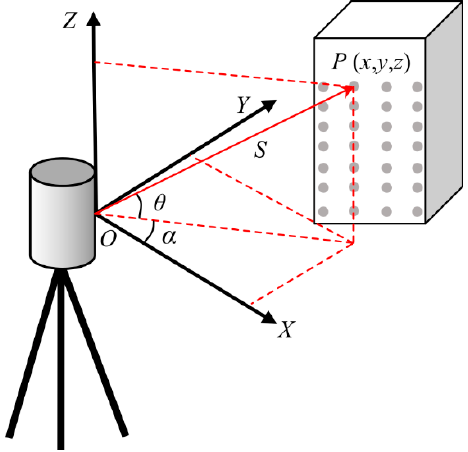
Figure 3. Measuring principle of the terrestrial laser scanning (TLS).